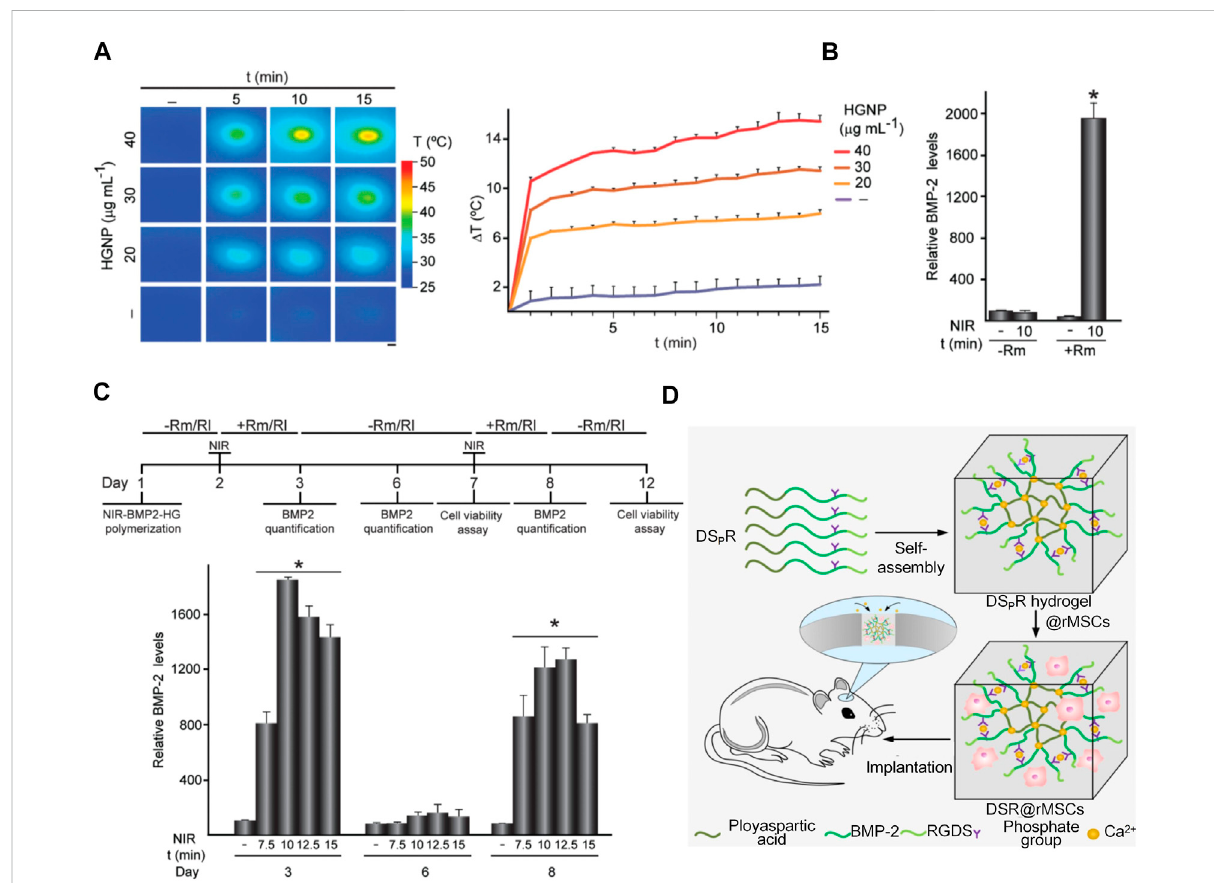
FIGURE 7 Application of hydrogels with photothermal effects and synthesis of biometic self-assembling peptide hydrogels. (A) NIR-BMP-2-HG, polymerized with the indicated concentrations of HGNP, incubated for 1 day, and then irradiated with NIR laser for the indicated time. Infrared thermalimage(left).The fi gureshowsthemean+SDvalueofthemaximumtemperaturerisedetectedduringNIRirradiation(right), n =3.Scalebar= 1 mm. (Pensak et al., 2015; Sanchez-Casanova et al., 2020)(Reprinted with permission) (B) BMP-2 concentration in media conditioned with 30 μ g ml-1 HGNP-polymerized NIR-BMP-2-HG. (Pensak et al., 2015; Sanchez-Casanova et al., 2020)(Reprinted with permission) (C) NIR-BMP-2- HG, aggregated with 30 μ g ml-1 HGNP, irradiated by NIR in the presence of 10 nM rapamycin (Rm) or 100 nM rapalog AP21967 (R1). Timeline protocol for NIR-BMP-2-HG preparation, NIR irradiation of hydrogels (NIR), in the absence (-Rm/Rl) or presence (+Rm/Rl) of rapamycin or rapalog and analytically determined cultivated undercircumstances. On days 3, 6, and 8, themedium was collected and replaced with fresh medium lacking dimers. Histogramsshow BMP-2 concentrationson days 3,6, and 8 inNIR-BMP-2-HG-conditioned media that were NIR-irradiated in thepresence of Rm for the indicated times (Pensak et al., 2015; Sanchez-Casanova et al., 2020)(Reprinted with permission). (D) Illustration of a 3D bioactive gel scaffold of self-assembled DSpR oligopeptides for repairing rat calvarial defects. (Quan et al., 2019)(Reprinted with